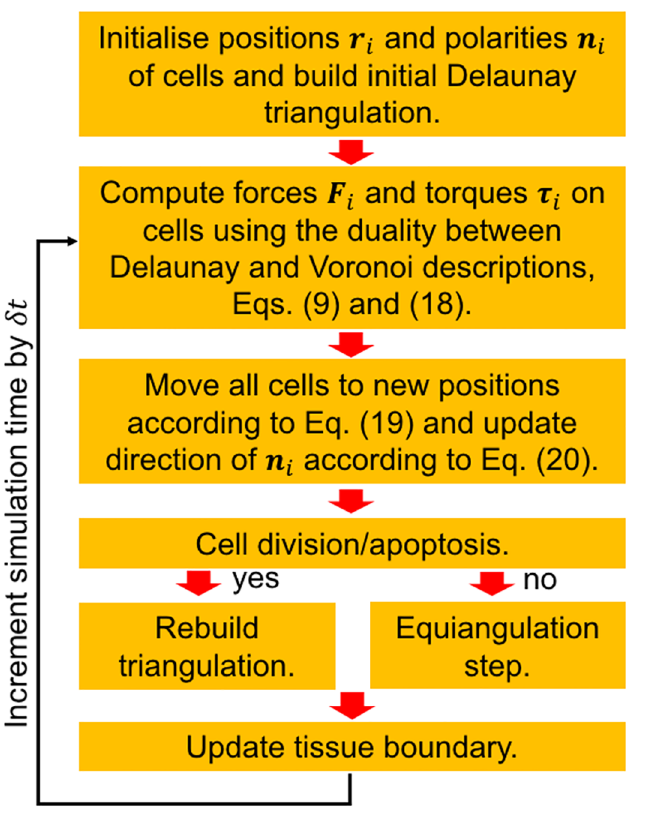
Fig 4. Flow chart of the force and torque calculations in each time step based on Eqs (7) and (12). The calculationspeedis significantly improvedby using the fast equiangulation moves shown in Fig 2c. The Delaunaytriangulation is recomputed only if there are cell divisionand/or death events, which do not occur at every time step.